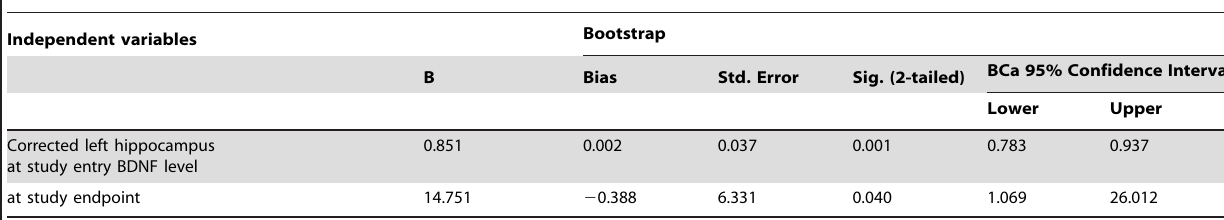
Table 5. Bootstrap for coefficients.